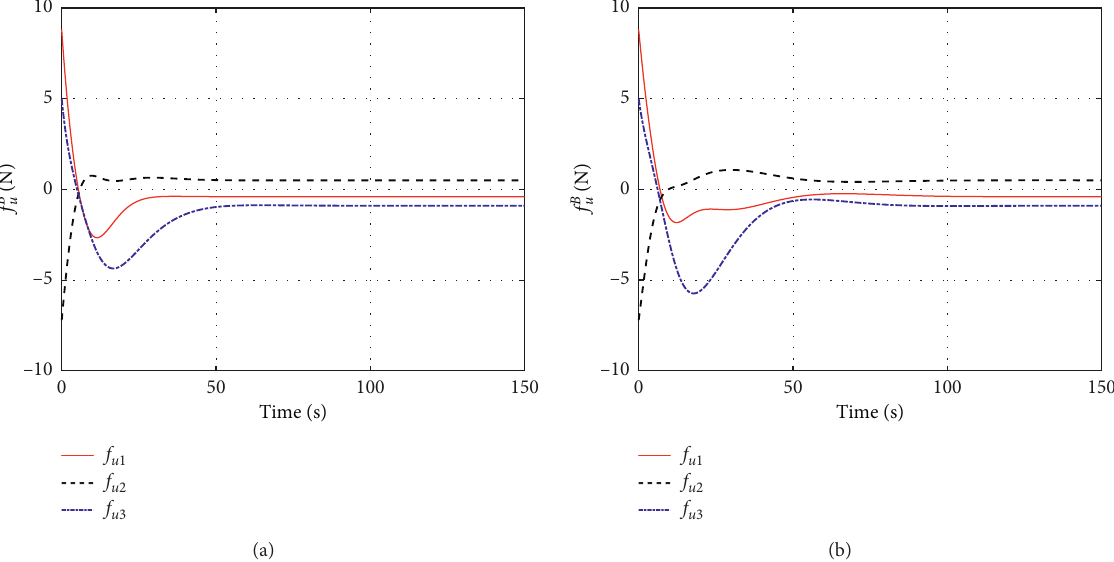
Figure 6: Control force. (a) Proposed I&I adaptive controller. (b) CE-based adaptive controller.